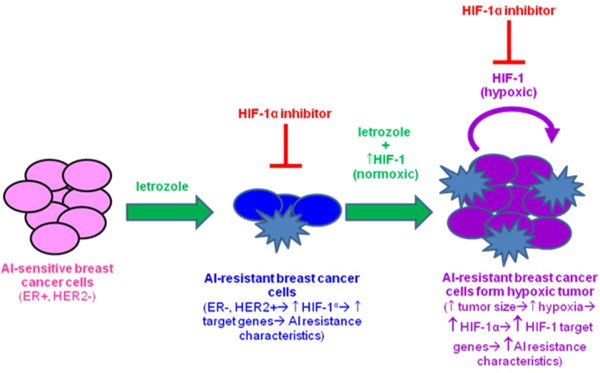
Proposed model of regulation and role of HIF-1α in AI resistant breast cancer.